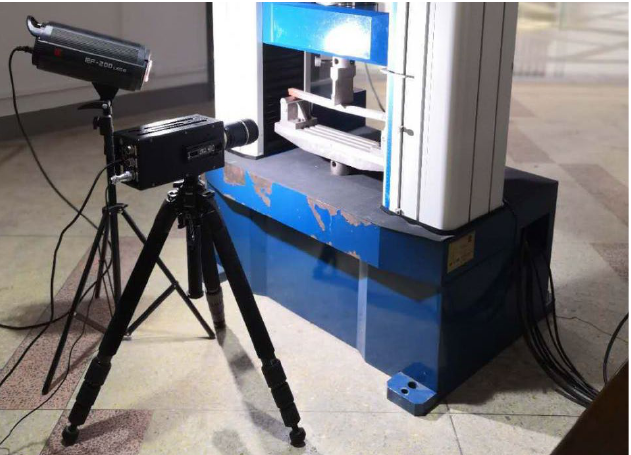
Figure 3. Experimental system for fracture of engineered bamboo using a high-speed camera.